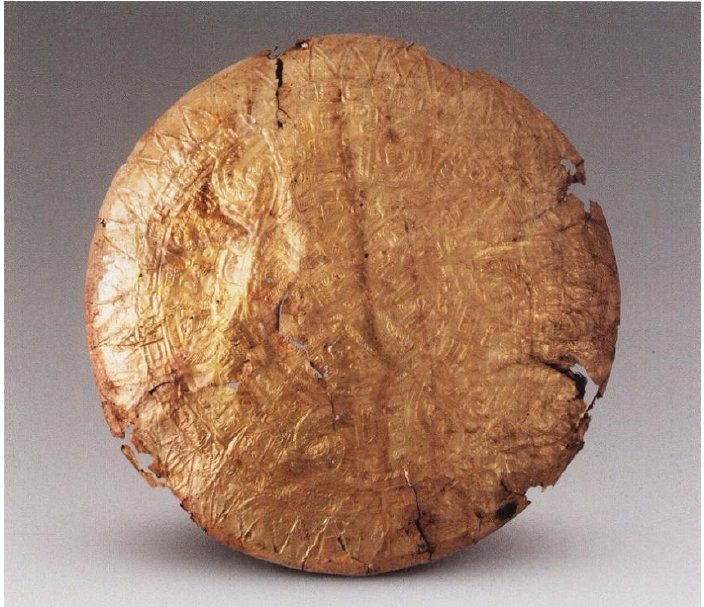
Figure 8. Round gold leaf from the late spring and autumn periods. Materials: gold. Dimensions: D. 14.4cm. Displayed in the Bengbu Museum, Anhui Province, China. Photo source: the official website of the Bengbu Museum 11 .